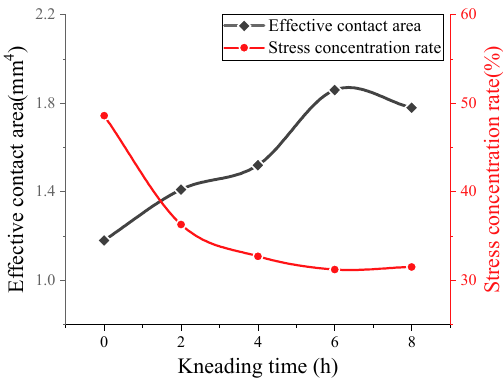
Figure 7. Attenuation of effective contact area and stress concentration rate.